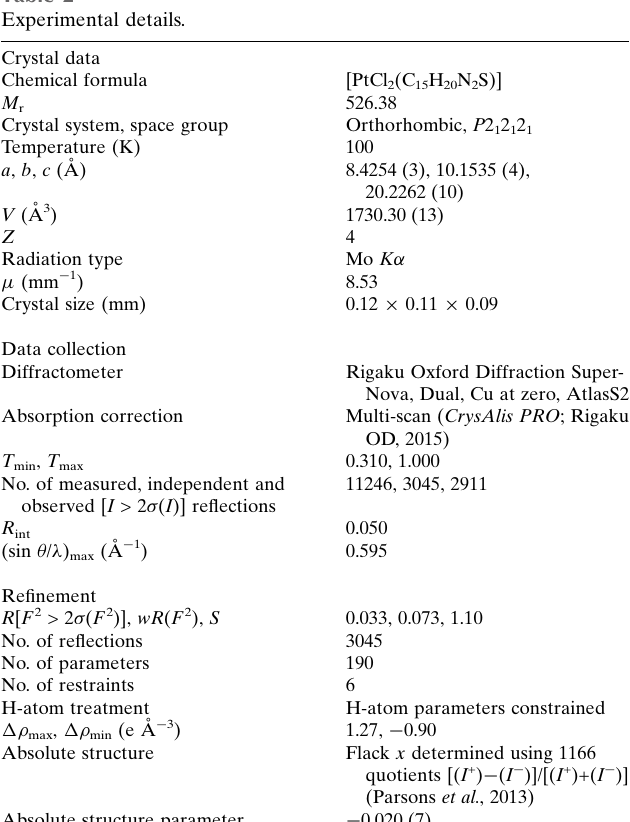
Table 2 Experimental details. Crystal data Chemical